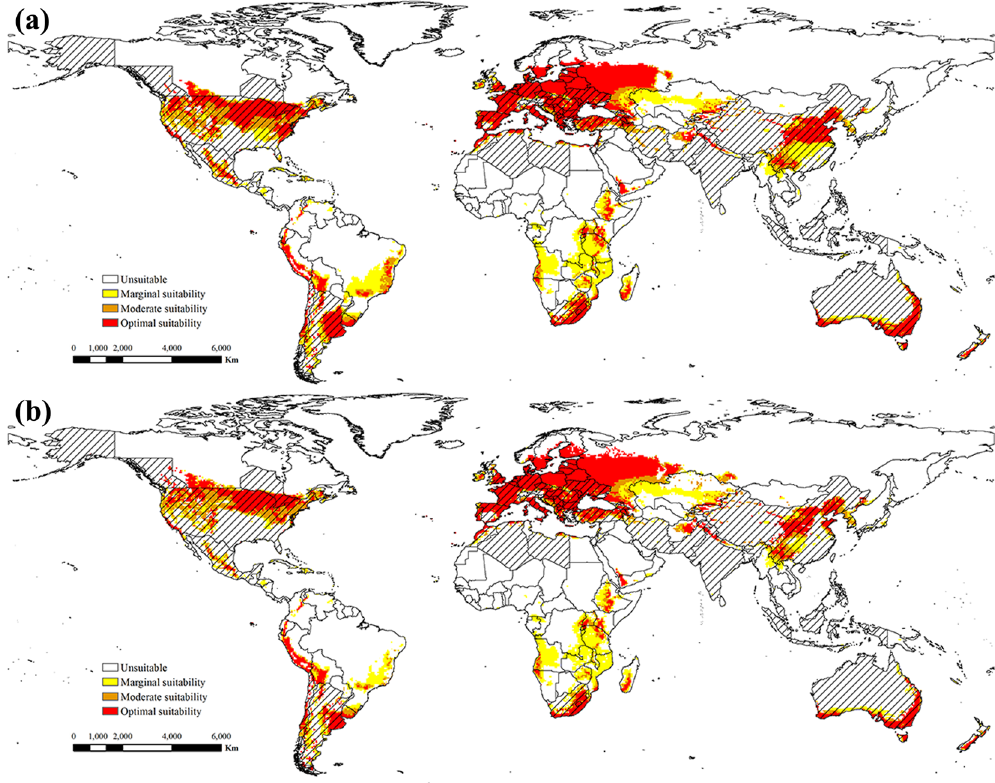
Figure 3. The projected global climate suitability for ESC under climate change scenario RCP 8.5, ( a ) the middle of 21st century (2046–2065), ( b ) the end of 21st century (2081–2100). Slash indicate the distribution countries of tree-of-heaven. Yellow indicates areas of marginal suitability (0 < EI ≤ 10); Orange indicates areas of moderate suitability (10 < EI ≤ 20); Red indicates areas of optimal suitability (EI ≥ 20). The map in this figure was generated by ArcGIS 10.1 (ESRI, Redlands, CA, USA,